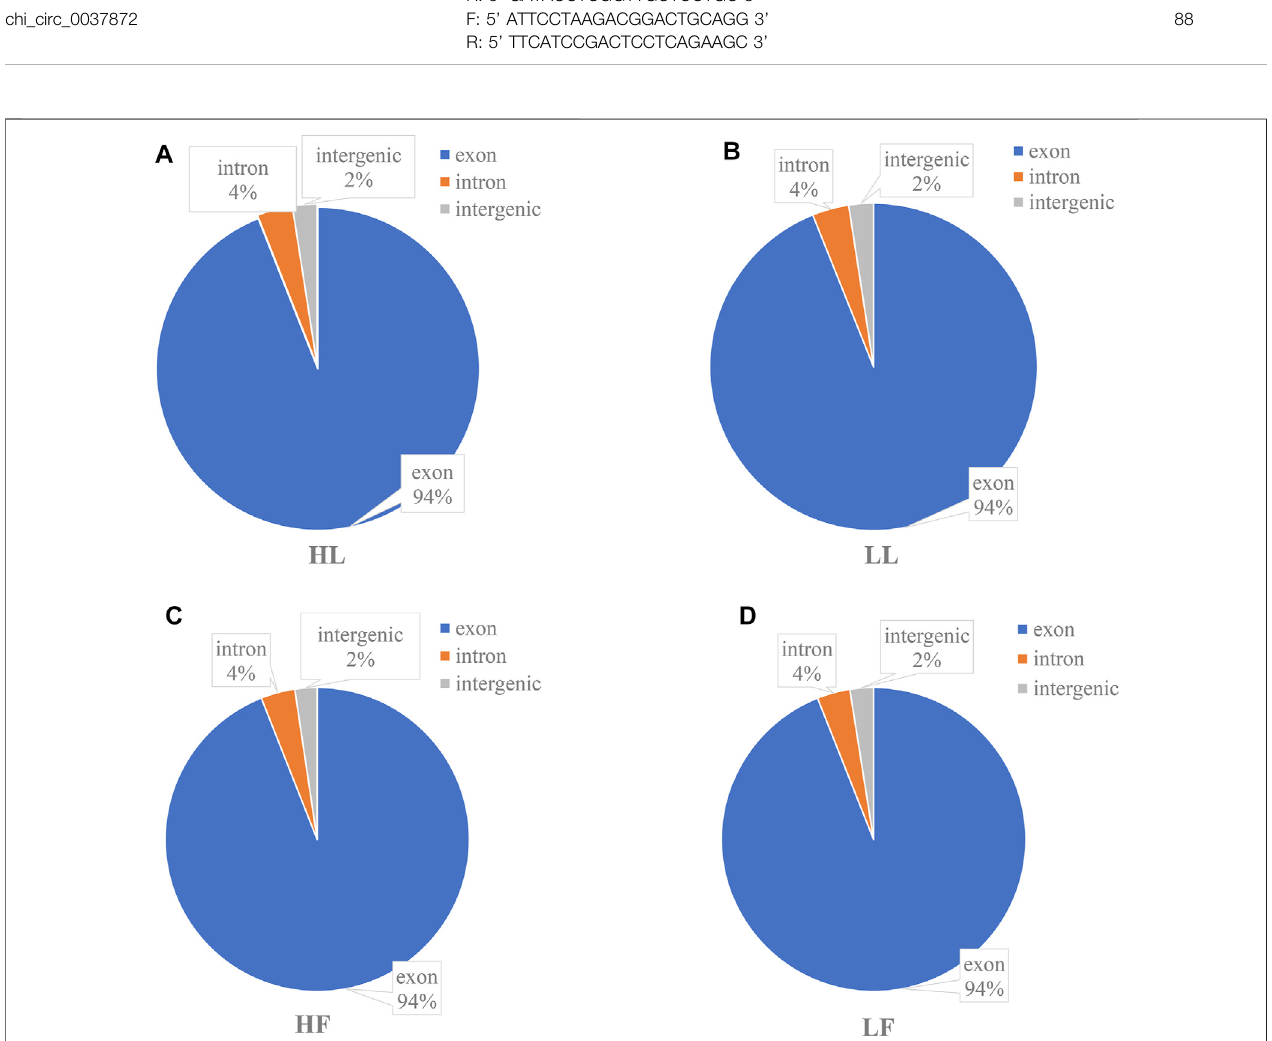
FIGURE1| The functionaland regionaldistributionofidenti fi edcircularRNAs. (A) The functionalregiondistribution ofcircularRNAsidenti fi ed inhigh-yield goats in the luteal phase, HL; (B) low-yield goats in the luteal phase, LL; (C) high-yield goats in the follicular phase, HF; and (D) low-yield goats in the follicular phase, LF.